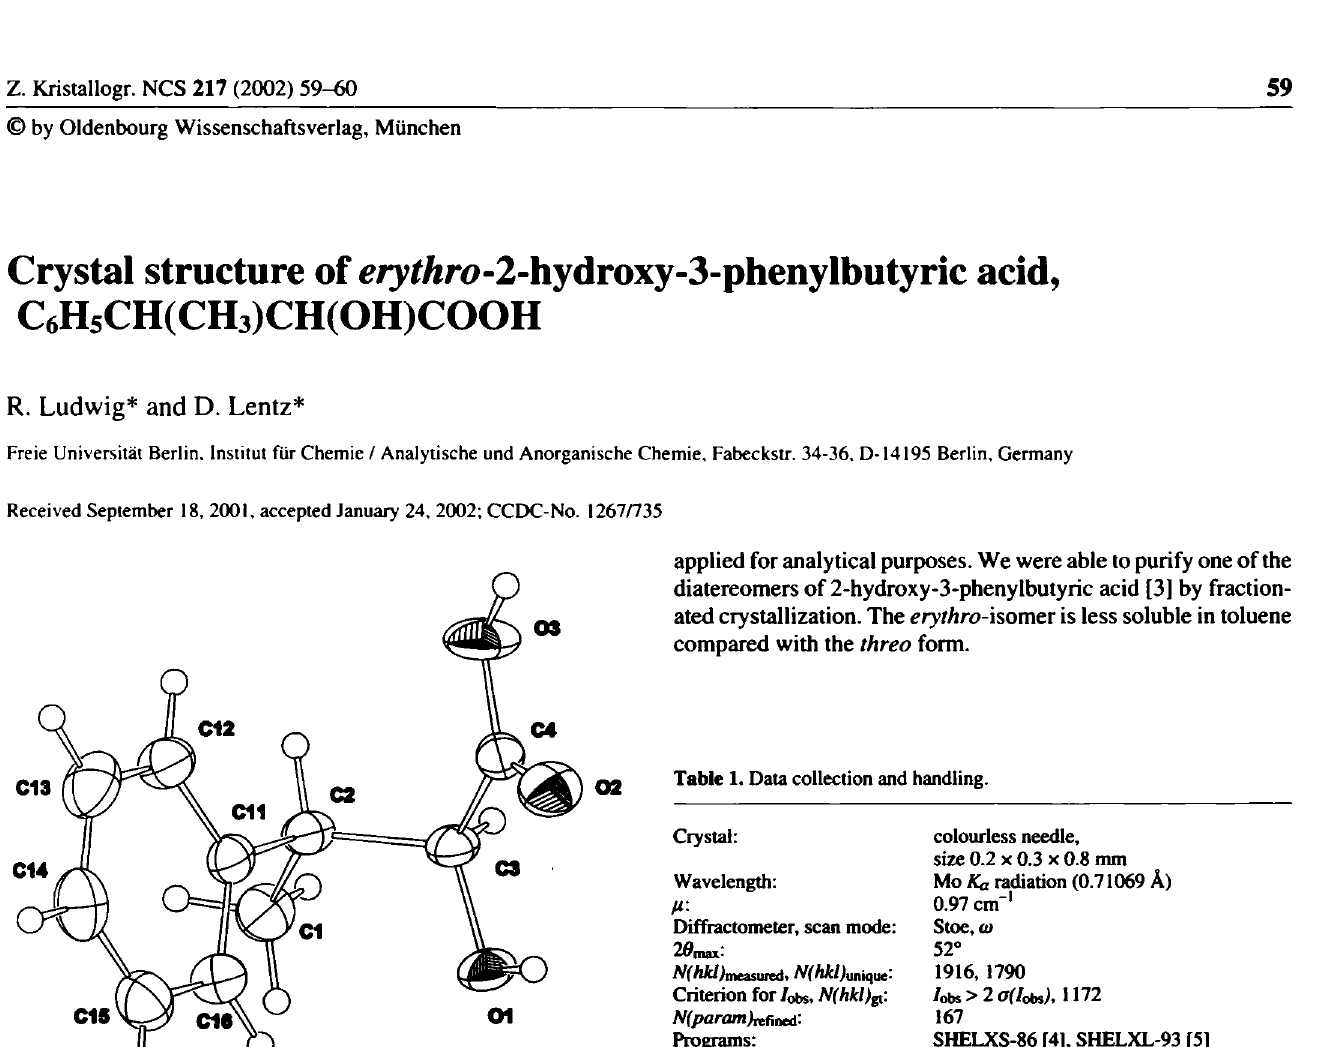
Table 2. Atomic coordinates and displacement parameters (in Â 2